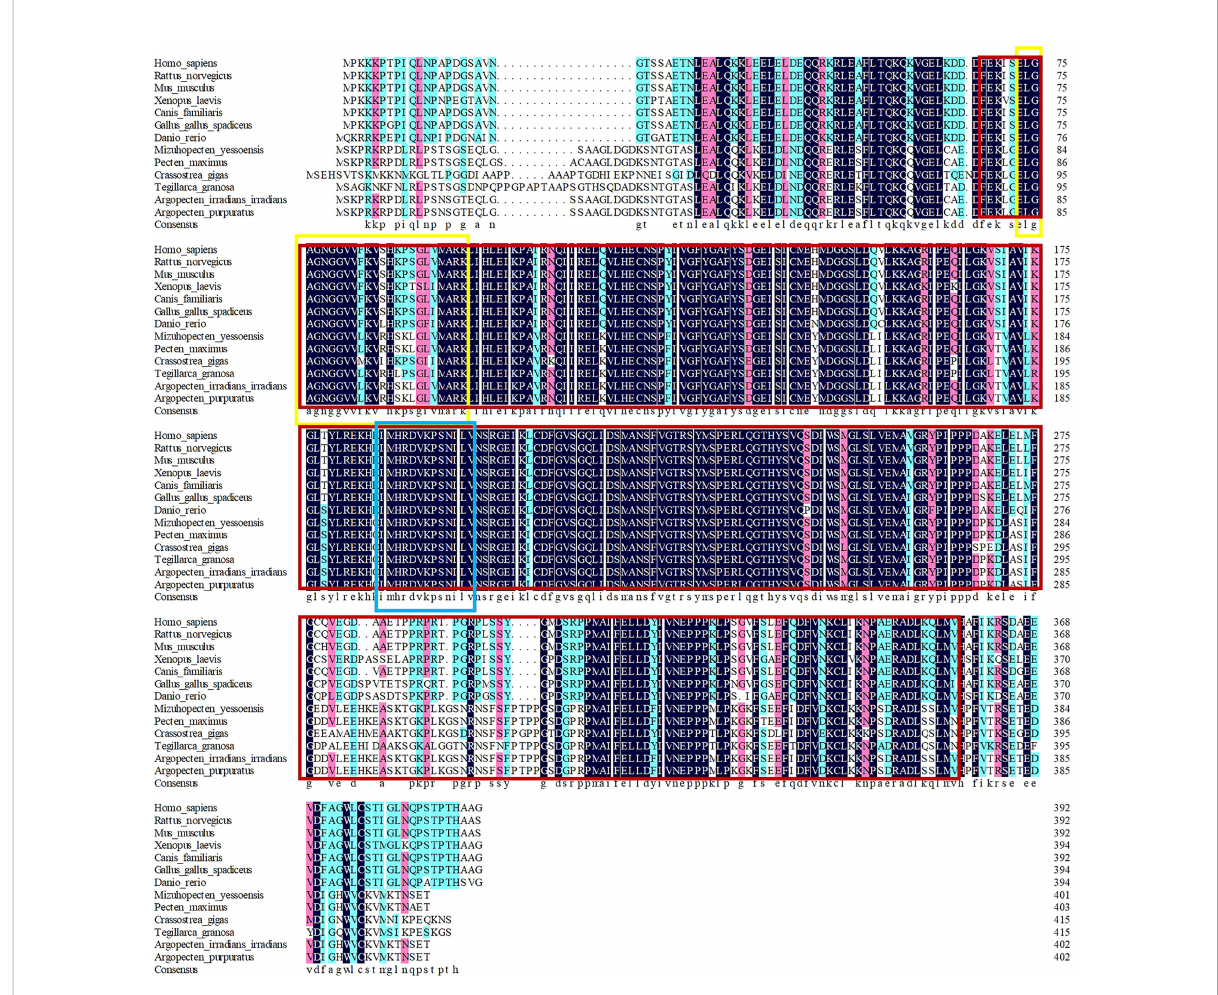
FIGURE 5 Multiple alignment of amino acid sequences. The red box indicates the region of the S_TKc domain, the yellow box indicates the ATP binding site of this domain and the blue box indicates the active site of